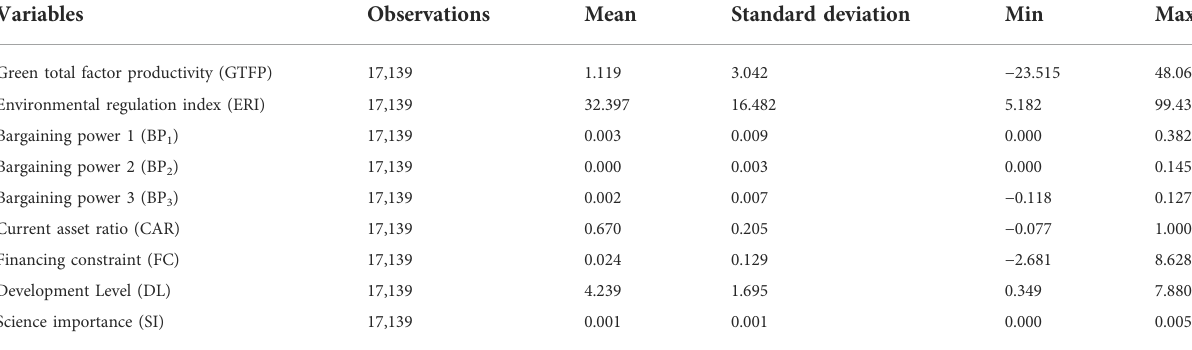
TABLE 1 Summary